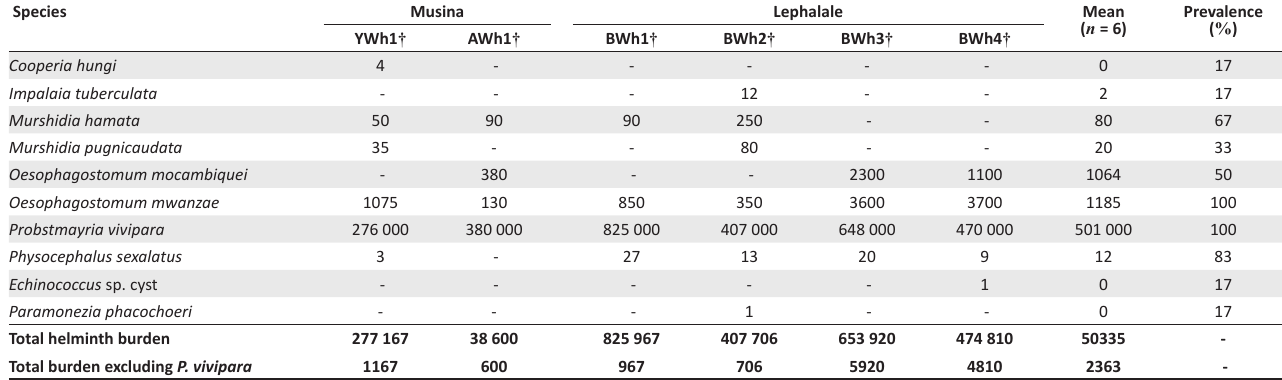
TABLE 5: Total helminth burdens of examined warthogs.